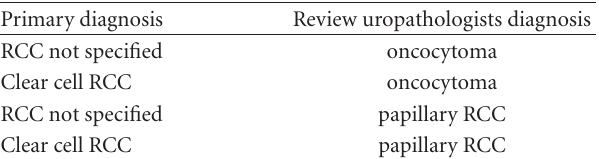
Table 4: Specifications of 4 subtype diagnoses that were di ff erently scored by primary pathology and review pathology. RCC: renal cell